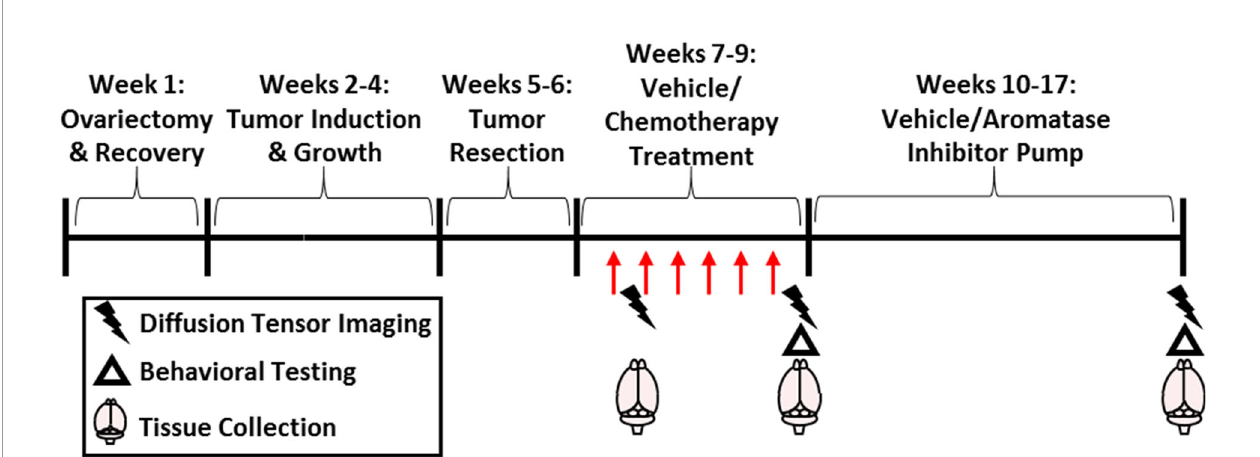
FIGURE 1 | Experimental Overview. Mice were ovariectomized followed by 1 week of recovery and then surgical mammary tumor induction. After 1.5 cm diameter tumor growth, the tumor was resected. Paclitaxel chemotherapy or vehicle (30 mg/kg; i.p.; 5-7 doses) with/without subsequent letrazole (10 µg/day over 57 days) or control treatment was administered. Brain imaging and tissue collection occurred after the fi rst dose of chemotherapy, after the fi nal dose, or after letrozole treatment. Behavioral testing was recorded after chemotherapy or letrozole